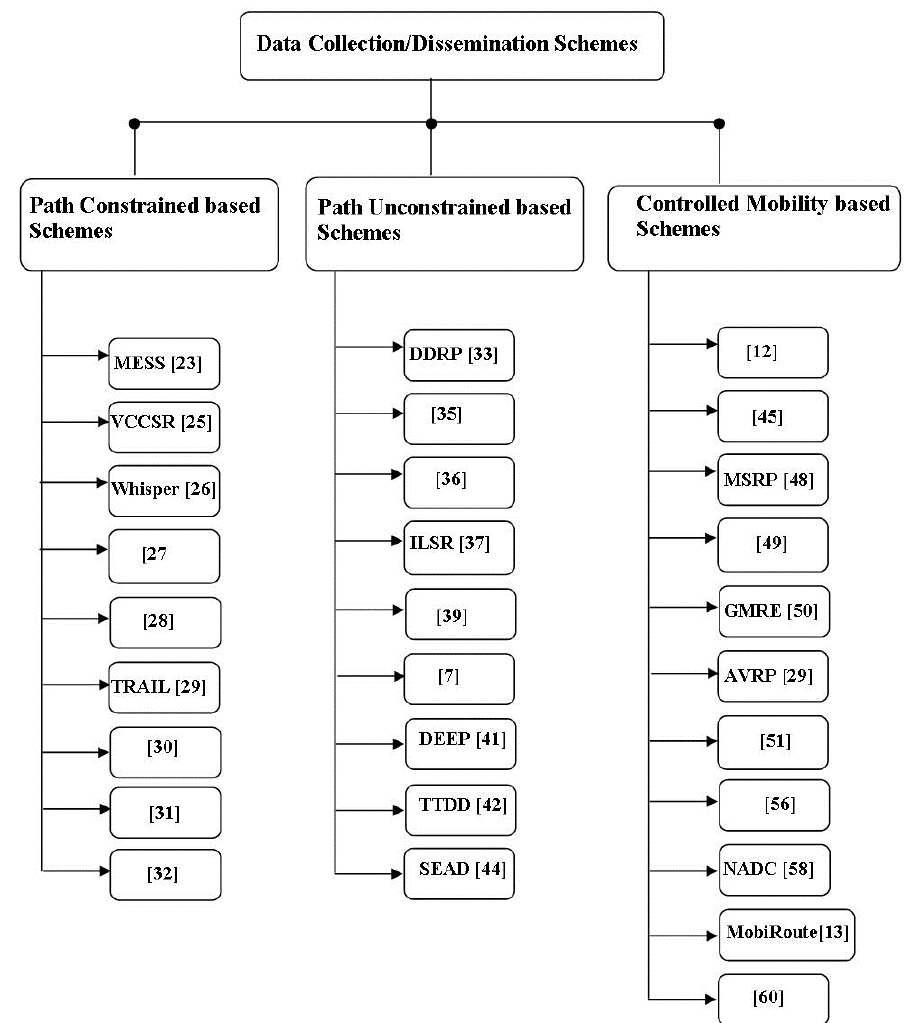
Figure 3. Classification of sink mobility based data collection/dissemination schemes.